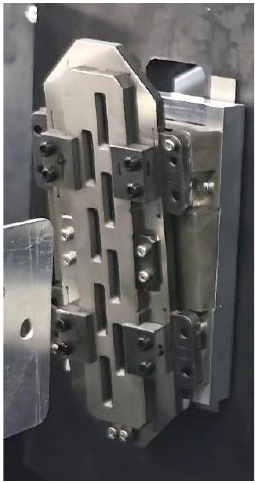
Figure 3. Assembly diagram of the multi-slit element.